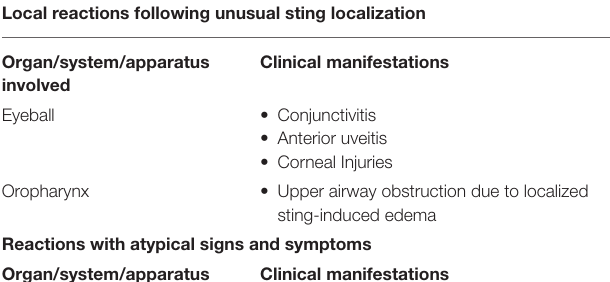
TABLE 1 | Unusual reactions to Hymenoptera